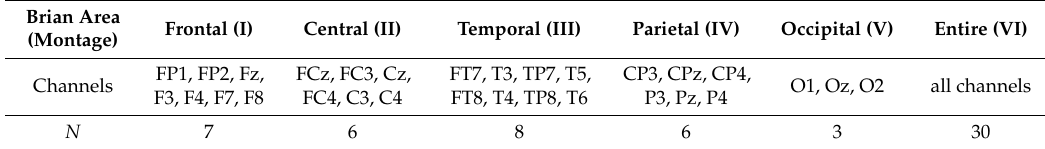
Figure 2. Six different montages selected for comparison in this study. The montages from I to VI cover the frontal, central, temporal, parietal, occipital, and entire scalp areas of the brain. Table 3. Six electrode montages and the numbers of channels of each.